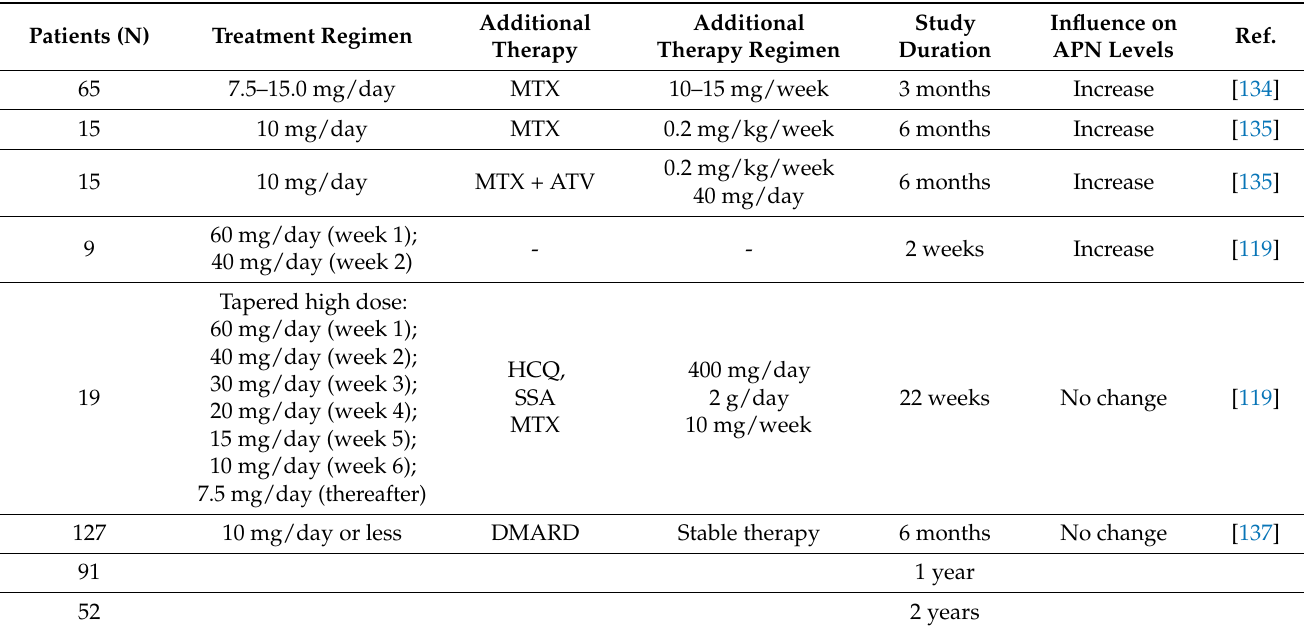
Table 3. Glucocorticoids (prednisolone) effects on circulating adiponectin levels in rheumatoid arthritis. Patients